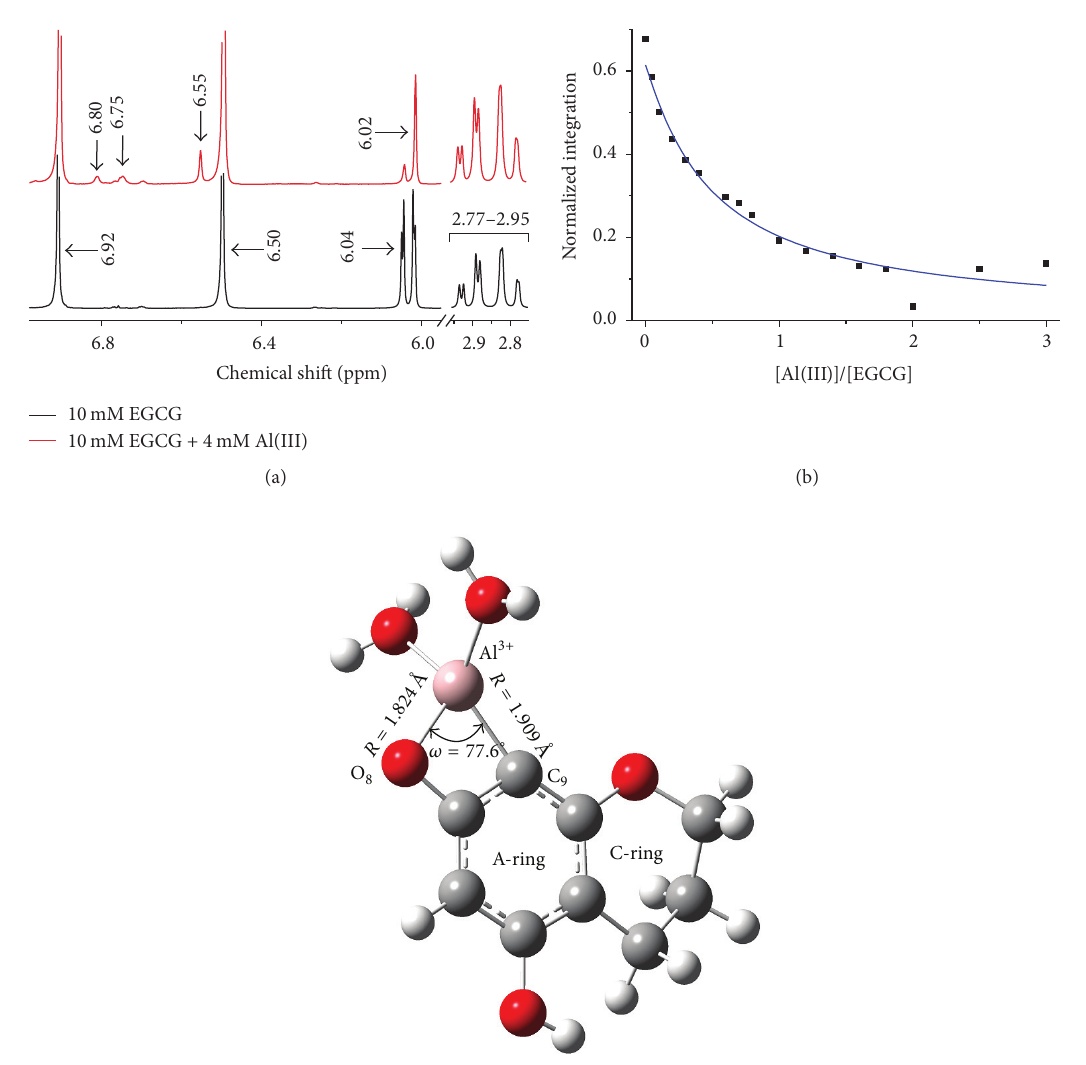
Figure 3: (a) 1 H NMR spectra of 10mM EGCG without (bottom) and with (top) 4mM Al(III). (b) The 1 H resonance integration at 𝛿 = 6.04ppm of C-9 in 10mM EGCG on the [Al(III) ]/[EGCG] ratio as the titration of Al(III) from 0 to 30mM. The values were normalized to 1 H integration within 2.77 to 2.95ppm of C-4. (c) Illustration of Al(EGCG)(H 2 O) 2 complex 1 (AE-1). Red, gray, pink, and white balls represent oxygen, carbon, aluminum, and hydrogen atoms, respectively. C 9 and O 8 in A-ring of EGCG and two more O atoms from H 2 O coordinate to the